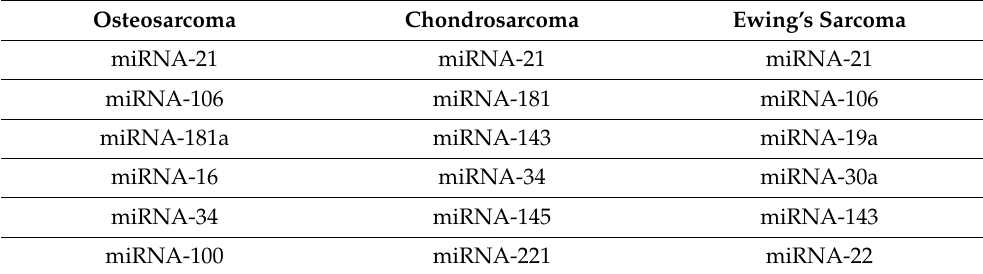
Table 2. List of microRNAs involved in Osteosarcoma, Chondrosarcoma, and Ewing’s Sarcoma.